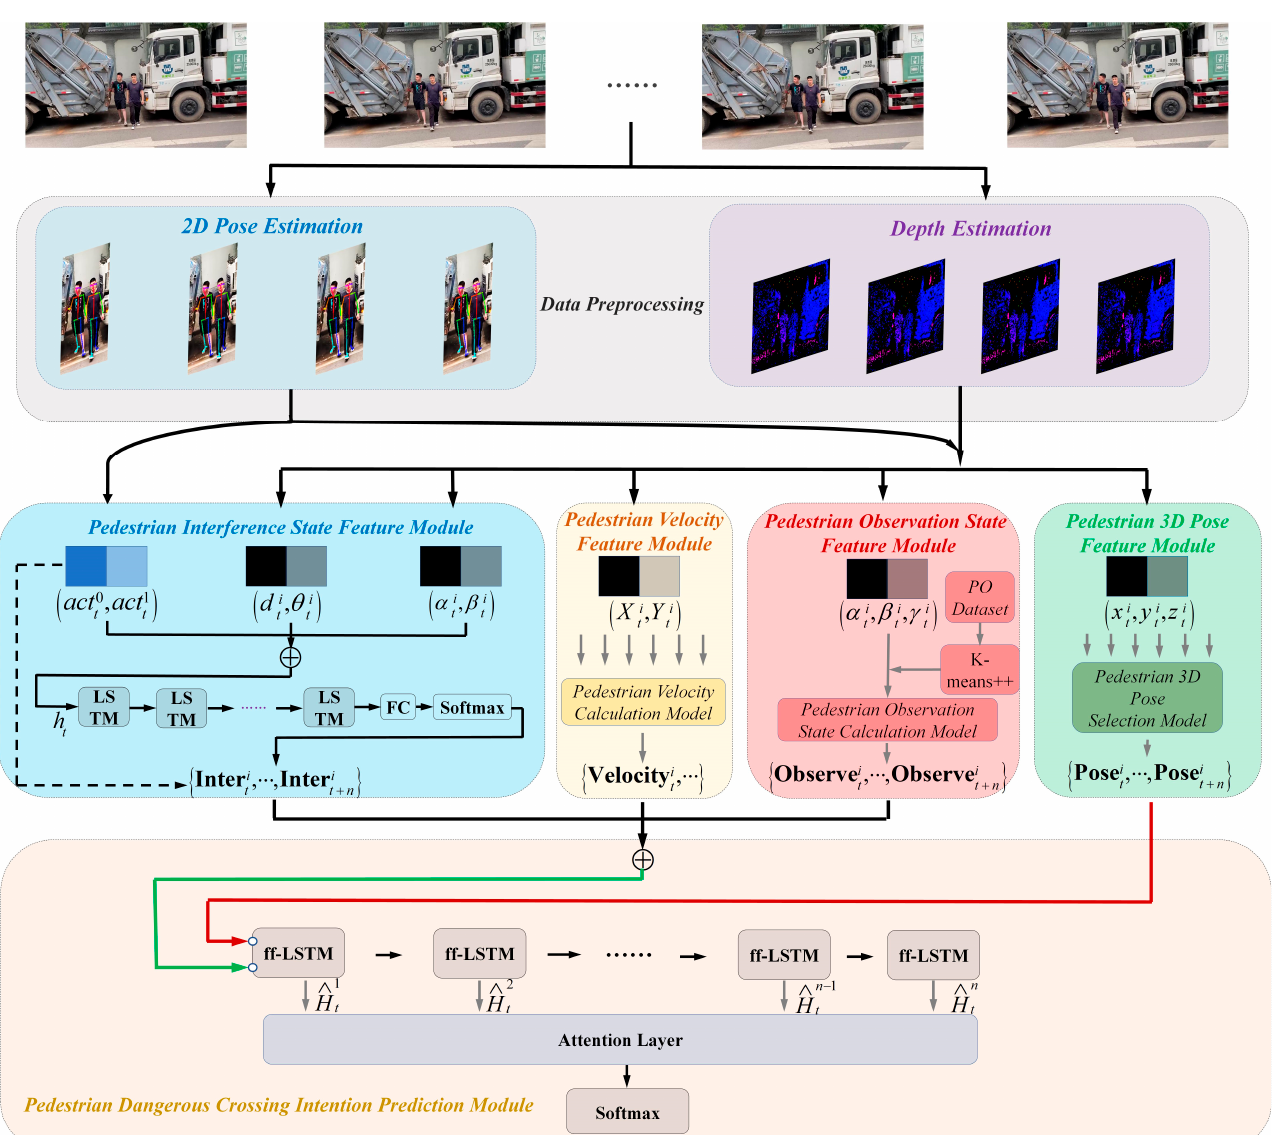
Figure 2. Schematic diagram of IPVO-LSTM structure, where “ ⊕ ” denotes concatenation. The PO Dataset is the body pose dataset of pedestrians when they observe the blind area. The pedestrian three-dimensional (3D) pose selection method is adopted to select the pedestrian closer to the center of the road at time t and retain their 3D pose information. The pedestrian observation state calculation method is mainly used to calculate the observation state of the studied pedestrians in the blind area at time t.